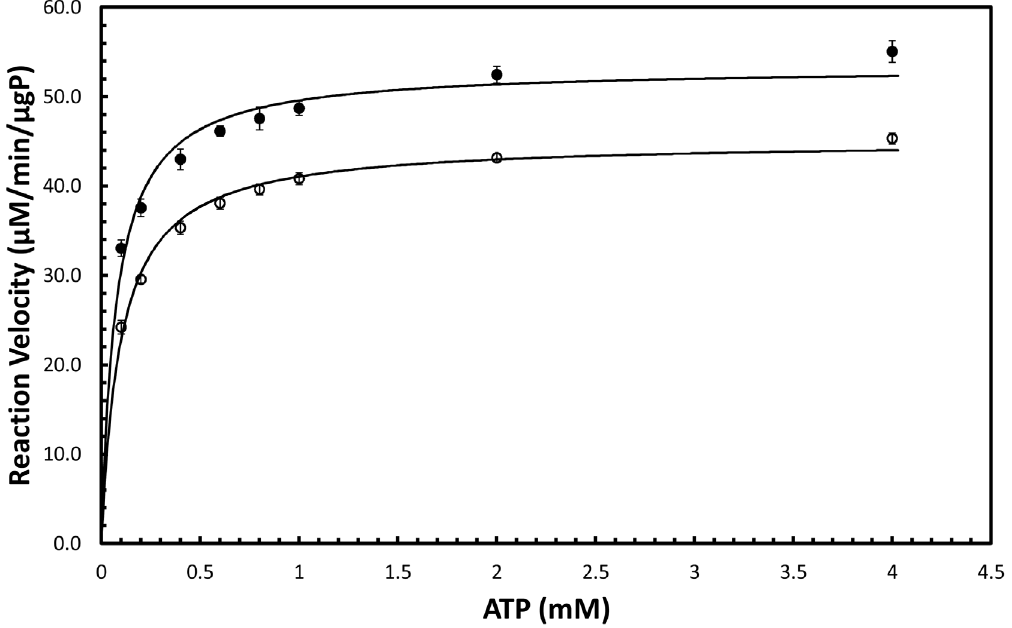
Figure 3. Initial reaction velocity as a function of ATP concentration. Closed circles are data for incubation at 37 u C and open circles are data for incubation at 30 u C.